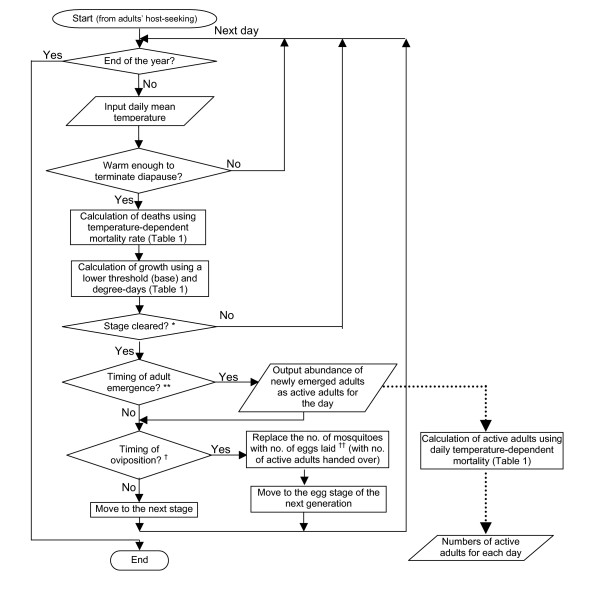
Flowchart illustrating the mosquito abundance model developed in the study. * Condition to clear the stages: ddx ≥ DDi (i specifying stages; 1 egg, 2 lava, 3 pupa, 4 adult) where, ddx is the accumulated degree-days till day x; DDi is the degree-days required to clear the stage i. ddx is calculated as follows:where tx is the daily mean temperature of the day x; t0 is the lower threshold temperature for dd accumulation (DDi and ti for each stage and species are presented in Table 1). ** Dependent upon accumulation of sufficient DD plus adult drying and host seeking period. † Dependent upon accumulation of sufficient DD for ovary development (presented in Table 1). †† Calculated as: (no. of female mosquitoes) × (no. of avg. gonotrophic cycles) × (avg. no. of eggs per gonotrophic cycle)